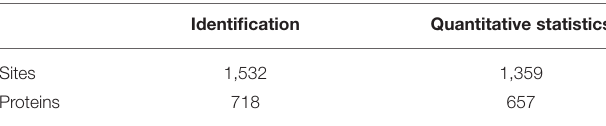
TABLE 5 | Identification and quantitative statistics of the modification of ubiquitinomics.